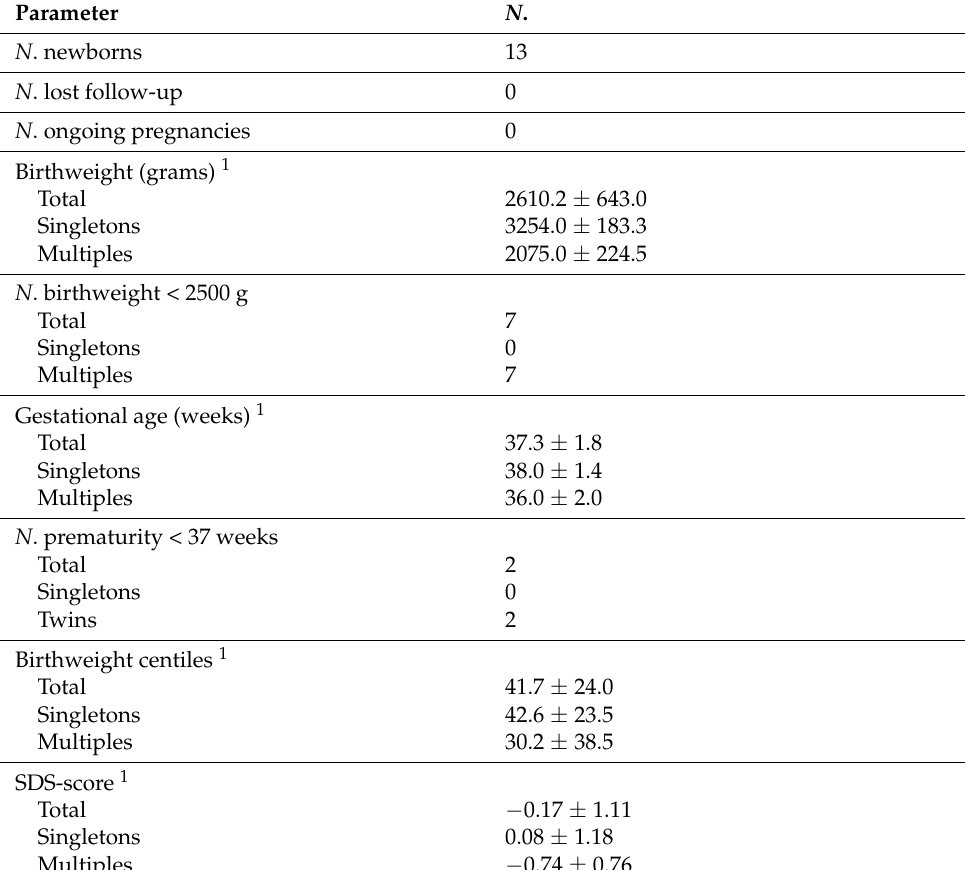
Table 2. Perinatal characteristics of